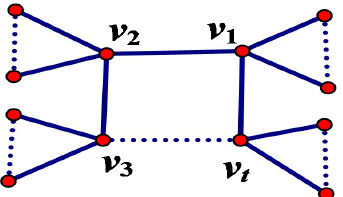
Figure 1: The unicyclic graph U